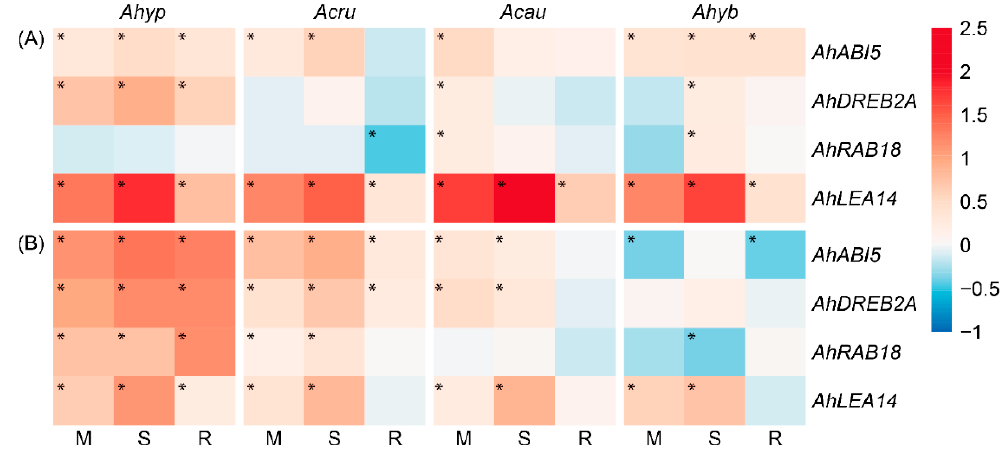
Figure 15. Relative expression of abscisic acid (ABA) marker genes in in ( A ) leaves and ( B ) roots of Amaranthus hypochondriacus (Ahypo), A. cruentus (Acru), A. caudatus (Acau), and A. hybridus (Ahyb) plants subjected to moderate (M) or severe (S) water deficit stress, or allowed to recover from S, 1 day after normal watering was restored (R). Induced (normalized expression values ≥ 1.5; in red) and repressed (normalized expression values ≤ 0.5; in blue) gene expression values, represented in a log 10 basis, are highlighted with an asterisk at the upper left side of the cells. They were calculated according to the comparative cycle threshold method [28] using the AhACT7 , AhEF1a and Ah β Tub5 amaranth genes for data normalization.